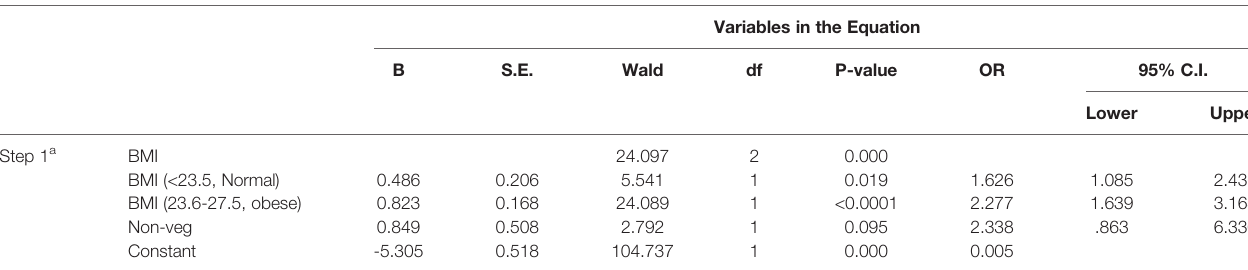
TABLE 6 | Logistic regression to see the association of BMI and food habit with IDRS scores.